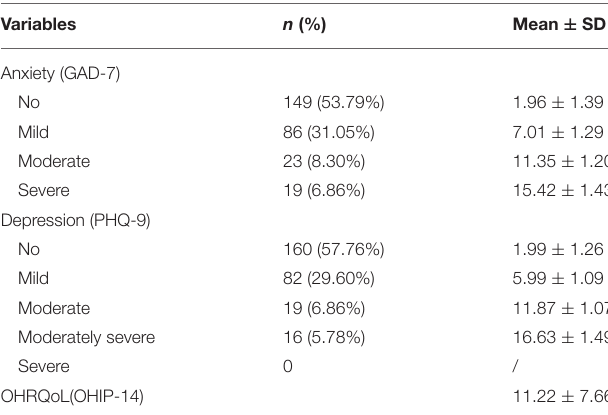
TABLE 2 | Level of anxiety, depression and OHRQoL among patients included in the